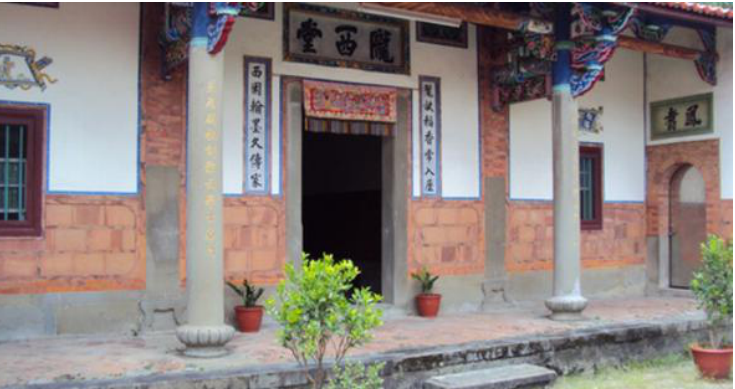
Figure 2. The characters Long Xi Tang 龍 西 堂 show that the house is inhabited by people belonging to the Clan Li 李 .